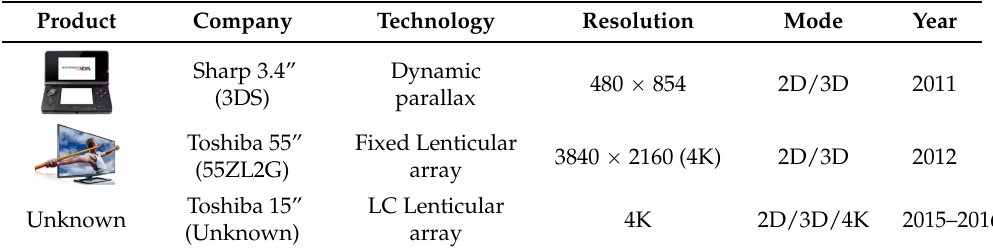
Table 1. Commercial examples of autostereoscopic devices based on spatial